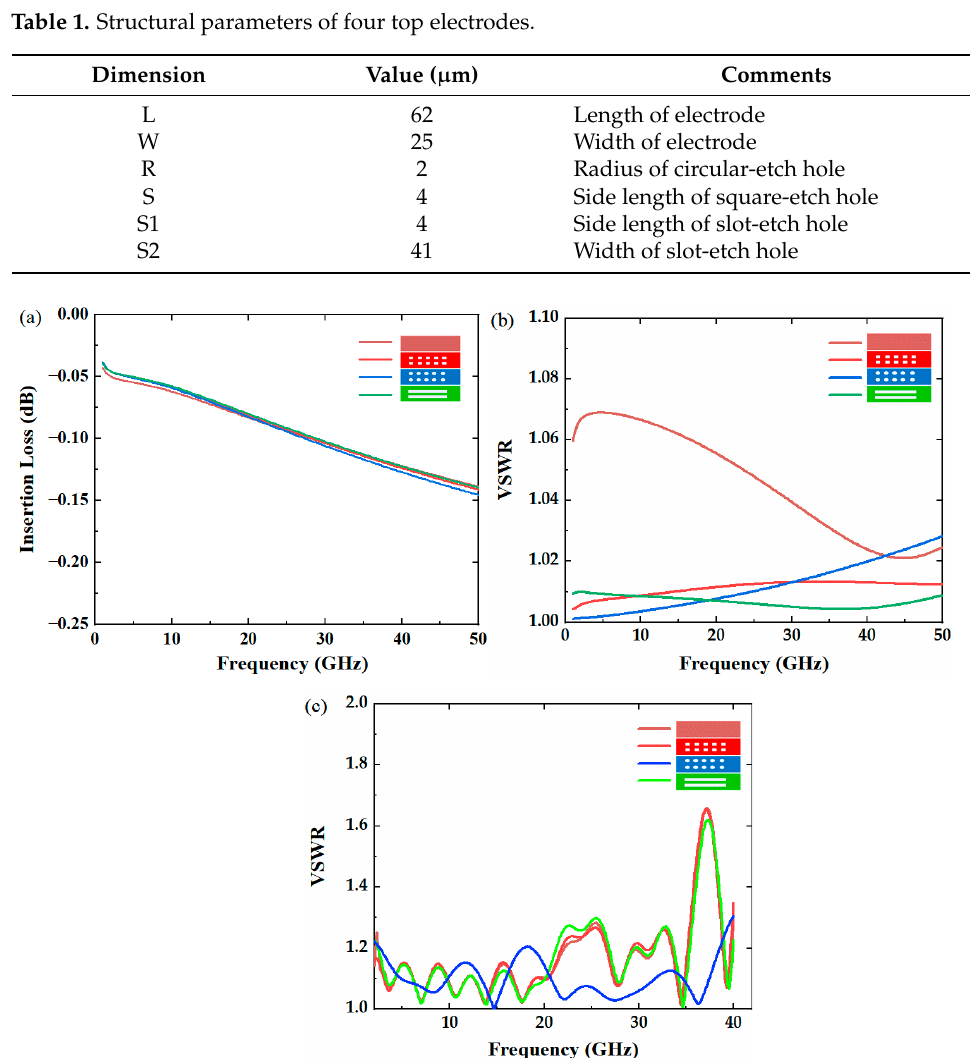
Figure 2. ( a ) Insertion loss (S 21 ) simulation results of four different types of top electrode switches. ( b ) Voltage standing wave ratio (VSWR) simulation results of four different types of top electrode switches. ( c ) VSWR of four release holes in State_3.